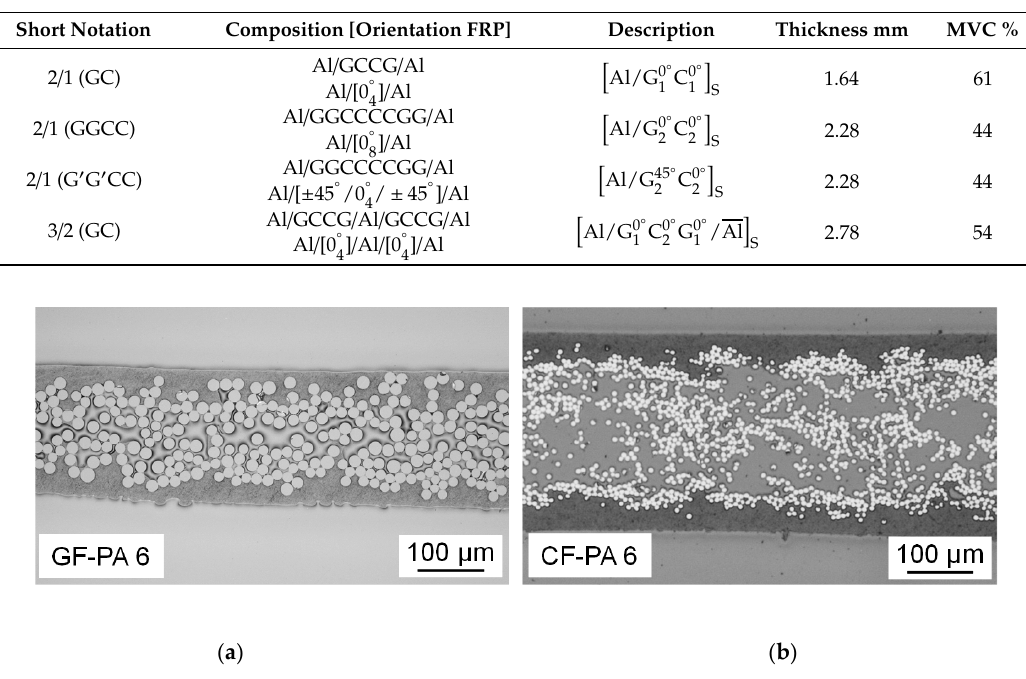
Table 1. Hybrid laminates of AA6082 and glass / carbon fibre-reinforced polyamide 6 with di ff erent layer structures and metal volume contents.